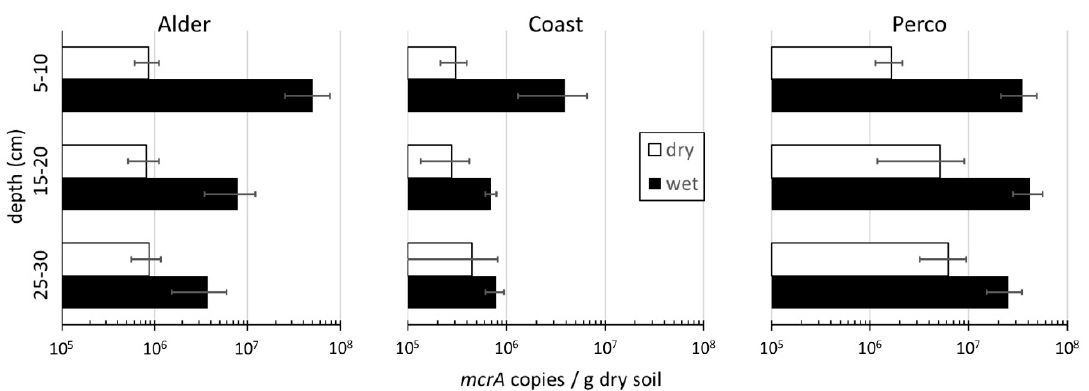
Figure 4. Abundance of methanogens. mcrA gene copy numbers per gram of dry soil based on qPCR. X-axis shows mcrA copies per g dry soil: drained sites in white, rewetted sites in black bars, and error bars show standard deviation of triplicate soil cores.